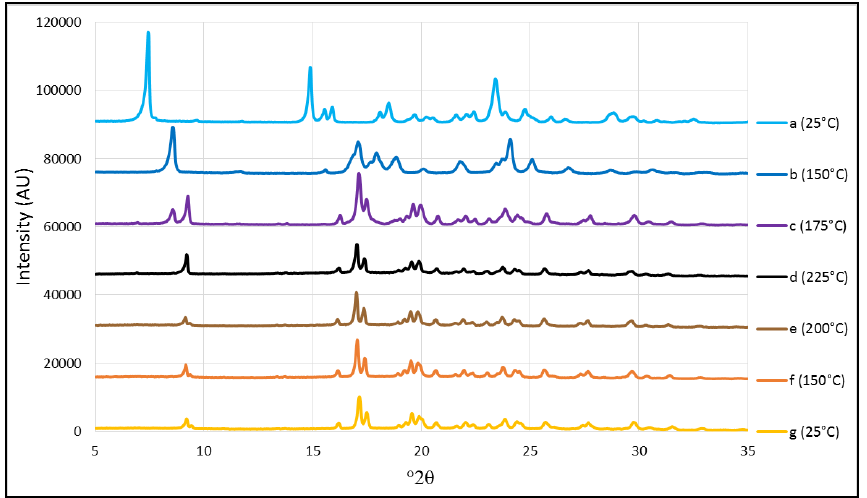
Figure 6. X-ray thermodiffraction patterns of pure TFV while heating to 25 °C (a), 150 °C (b), 175 °C (c) and 225 °C (d); and then while cooling to 200 °C (e), 150 °C (f) and 25 °C (g).